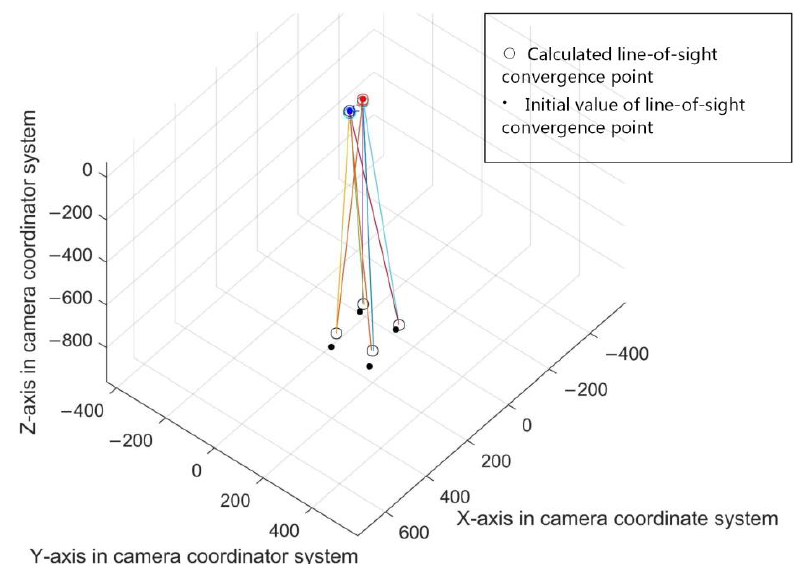
Figure 11. The calibration result in one step.